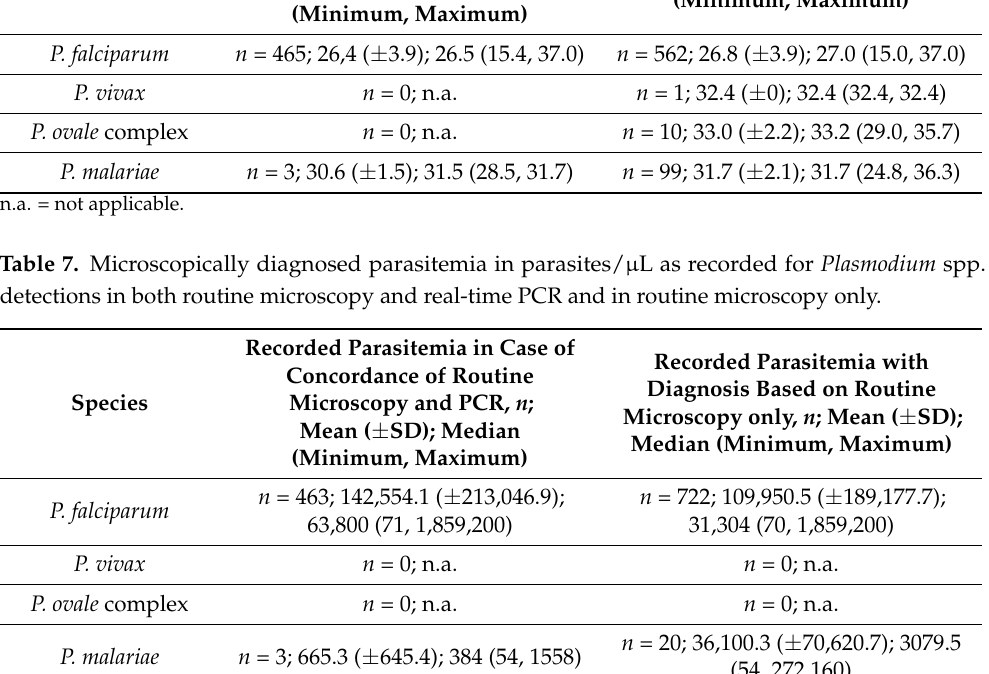
Table 6. SybrGreen-based screening PCR Ct values of Plasmodium spp. detections for samples that were positive in both routine microscopy and real-time PCR and in real-time PCR only ( n = 2114). Recorded Ct-Values in Case of Recorded Ct-Values with Concordance of Routine Diagnosis Based on PCR only, n ; Microscopy and PCR, n ; Species Mean ( ± SD); Median Mean ( ± SD); Median (Minimum, Maximum) (Minimum, Maximum) P. falciparum n = 465; 26,4 ( ± 3.9); 26.5 (15.4, 37.0) n = 0; n.a.